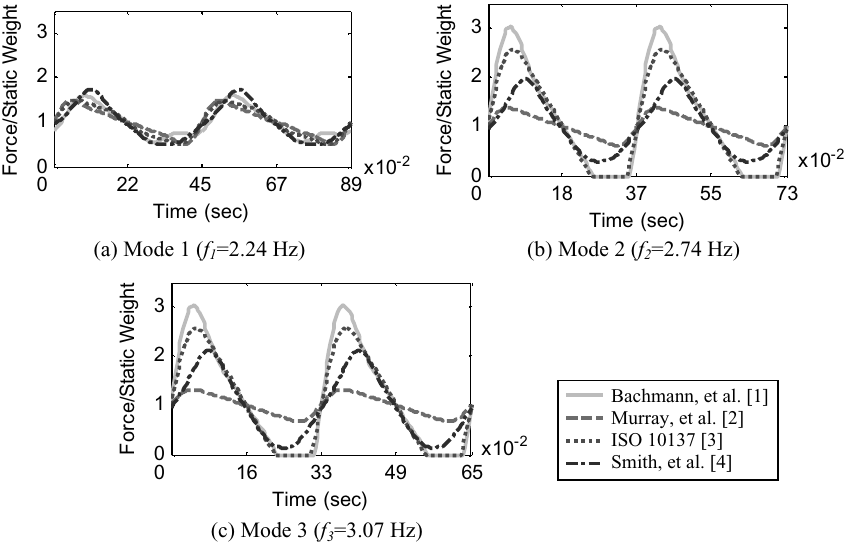
Fig. 8. Resonance walk forcing function for each mode based on Fourier